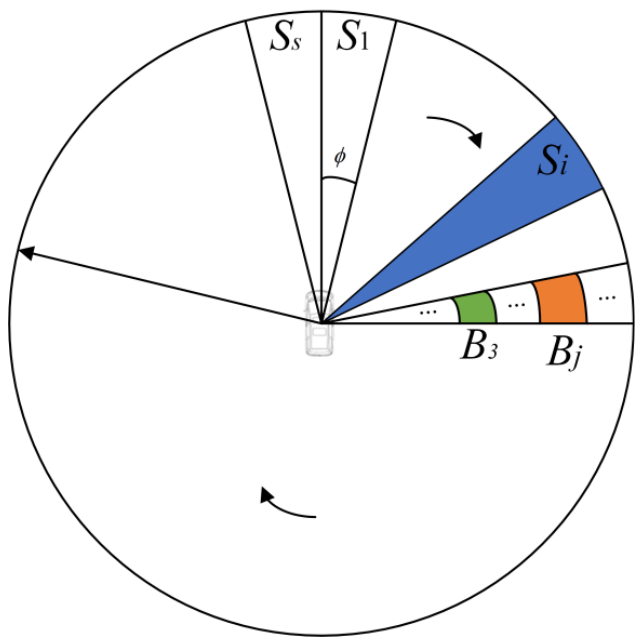
Figure 2. Schematic diagram of point cloud coordinate projection.